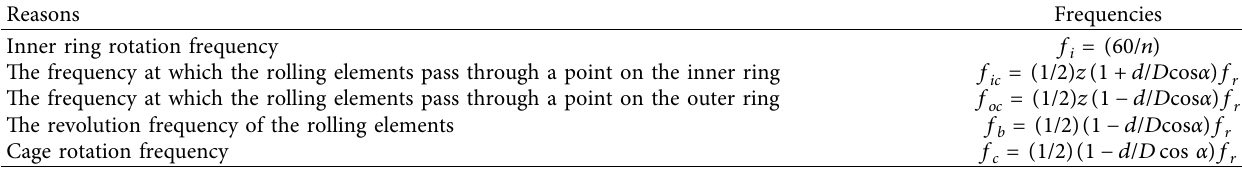
Table 1: Possible peak frequencies and causes of bearing noise.